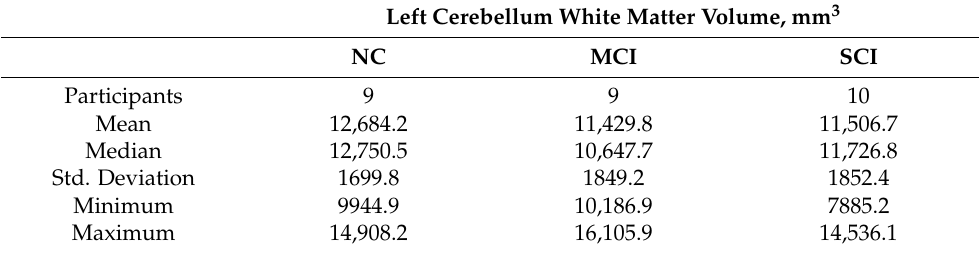
Table 2. Descriptive statistics for left cerebellum white matter volume in participants with normal cognition (NC), mild cognitive impairment (MCI), and moderate/severe cognitive impairment